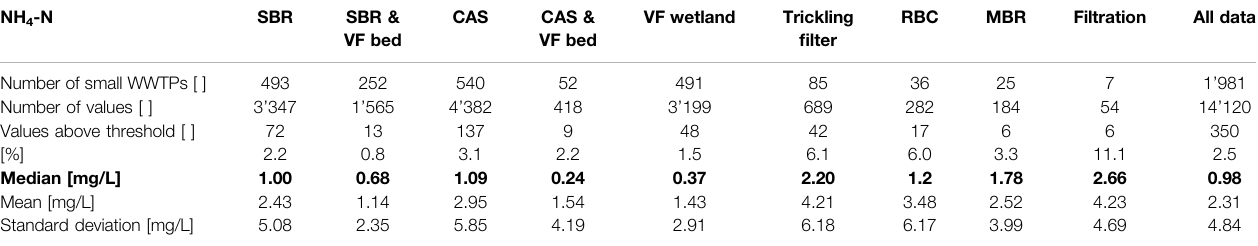
Bold values indicate the median values.